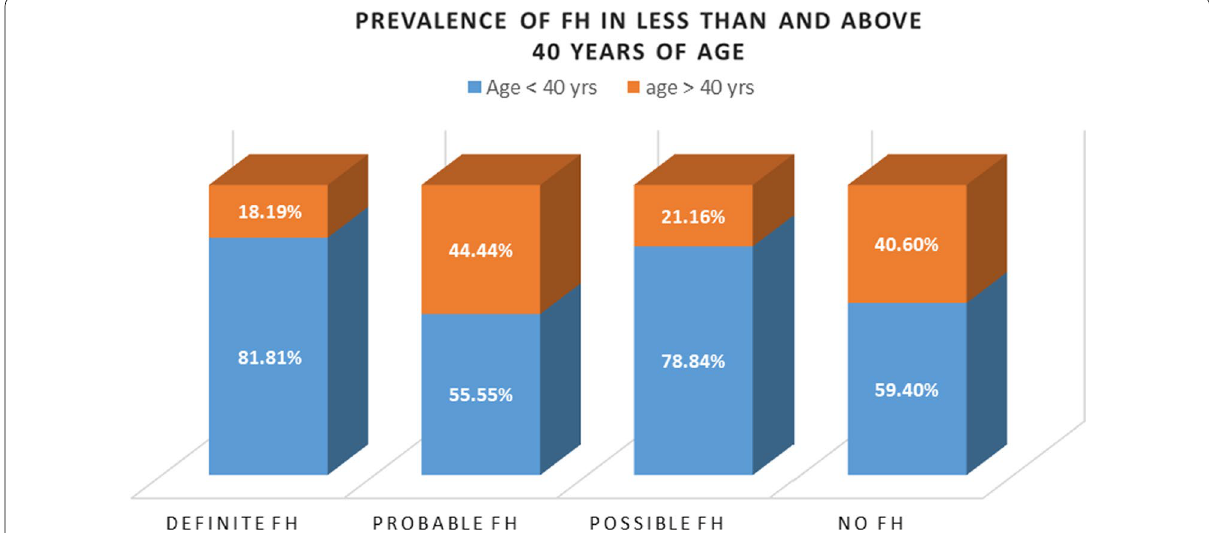
Fig. 2 The relative percentage of premature CAD patients that were classified by using the most effective DLCN (Dutch Lipid Clinic Network) criteria grouped into two age categories. The less than 40 years of age group showed more prevalence in definite and possible FH types